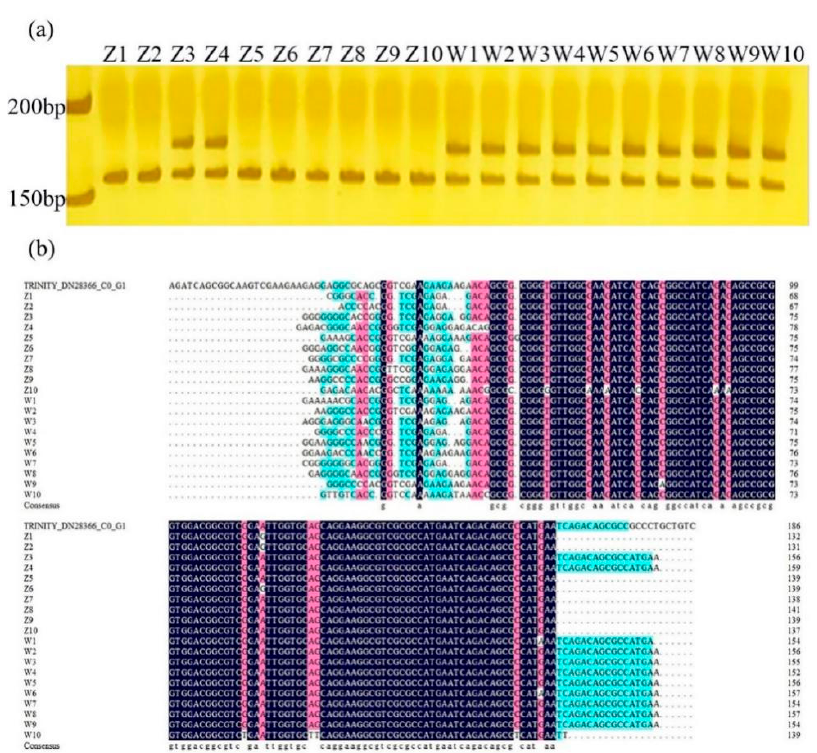
Figure 4. The flowering days of 20 E. sibiricus germplasms from 1 January 2018.